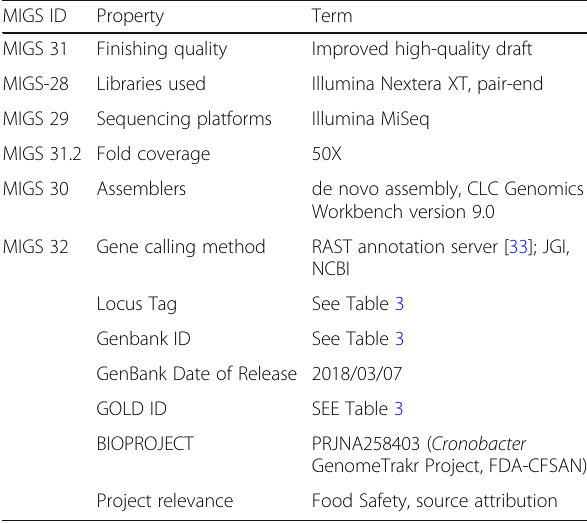
Table 2 Minimum information about a genome sequence (MIGS); project information for the 26 spice- associated C. sakazakii